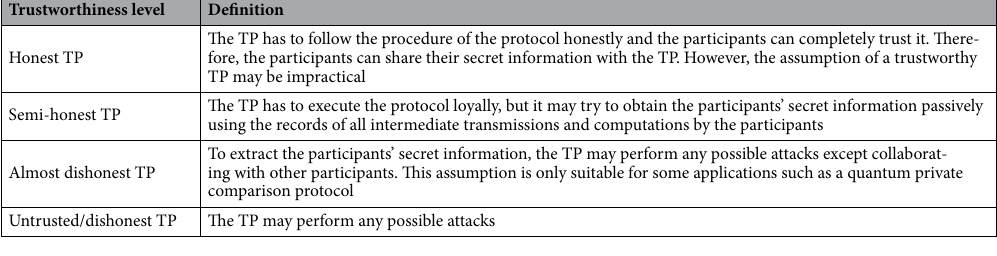
Table 2. Trustworthiness levels of